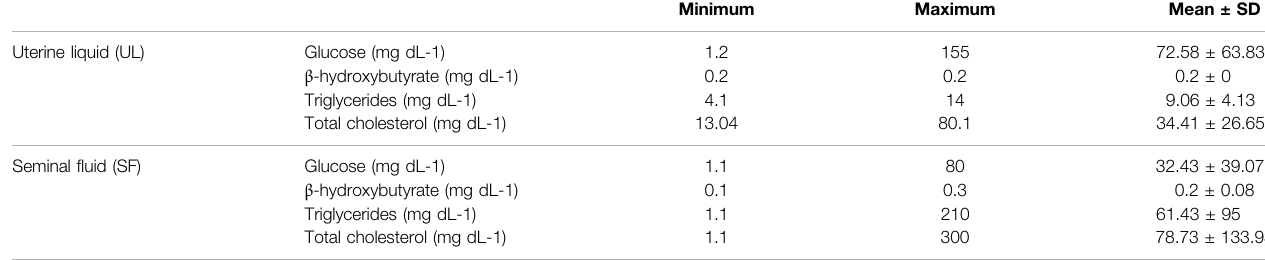
TABLE 1 | Minimum, maximum, and mean concentrations, and standard deviations of the analyzed seminal and uterine fl uid P. horkelii markers. Concentrations are presented in mg dL − 1 .